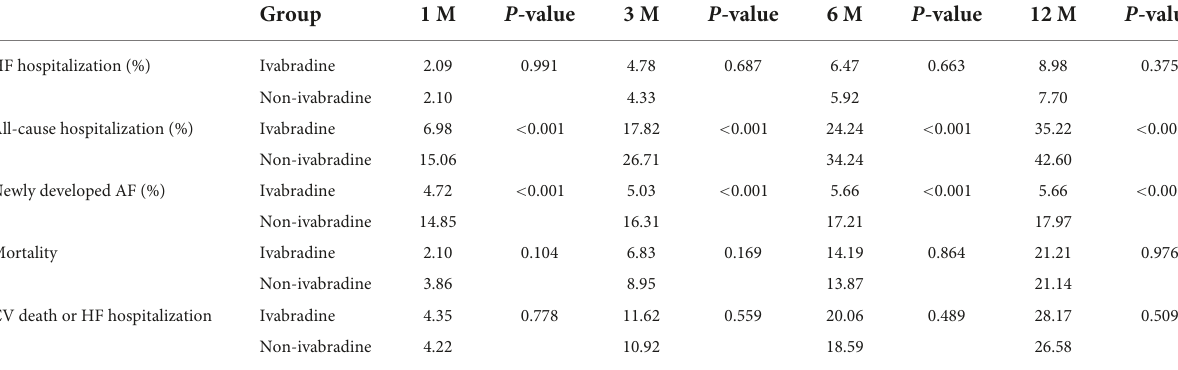
TABLE 2 The incidence of clinical outcomes at different time points between the ivabradine and non-ivabradine groups after IPTW.